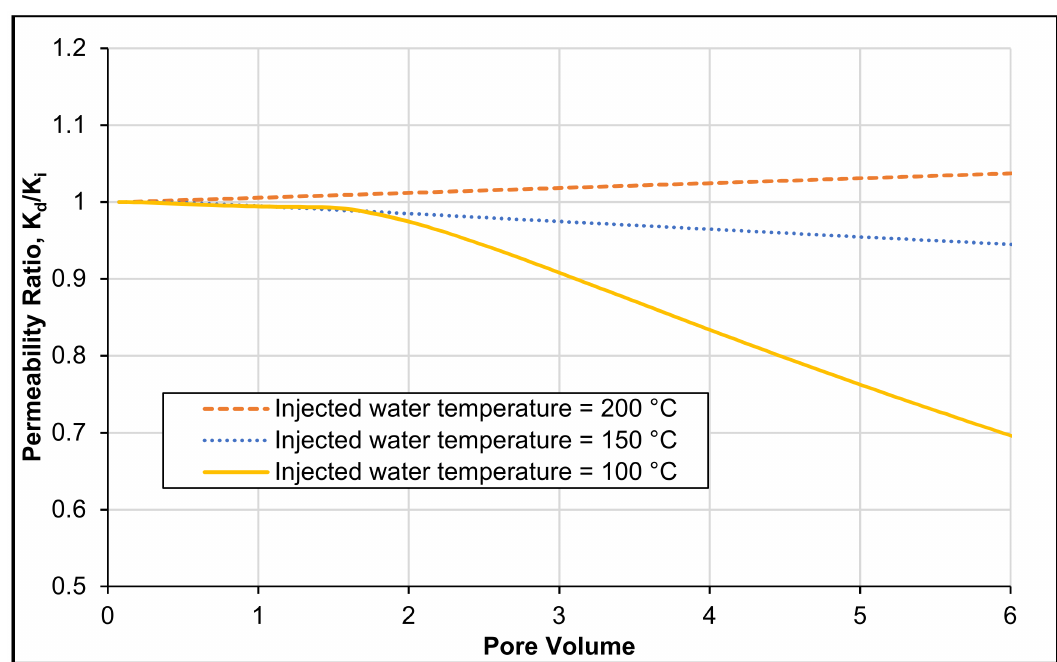
Figure 5. Effect of injected water temperature on formation permeability ratio for the first gridblock at 6 PVs with fixed reservoir temperature of 200 ◦ C.